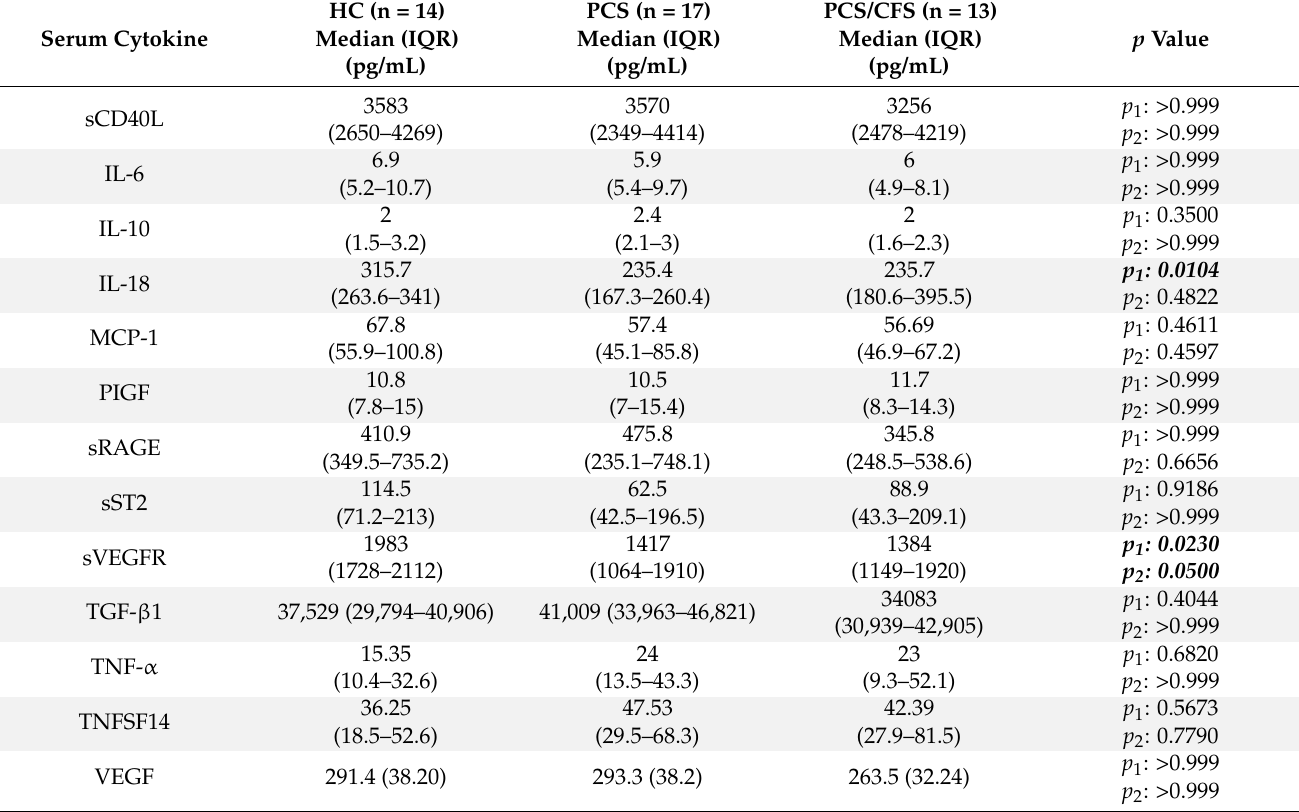
Table 2. Concentration of serum cytokines across patient and control